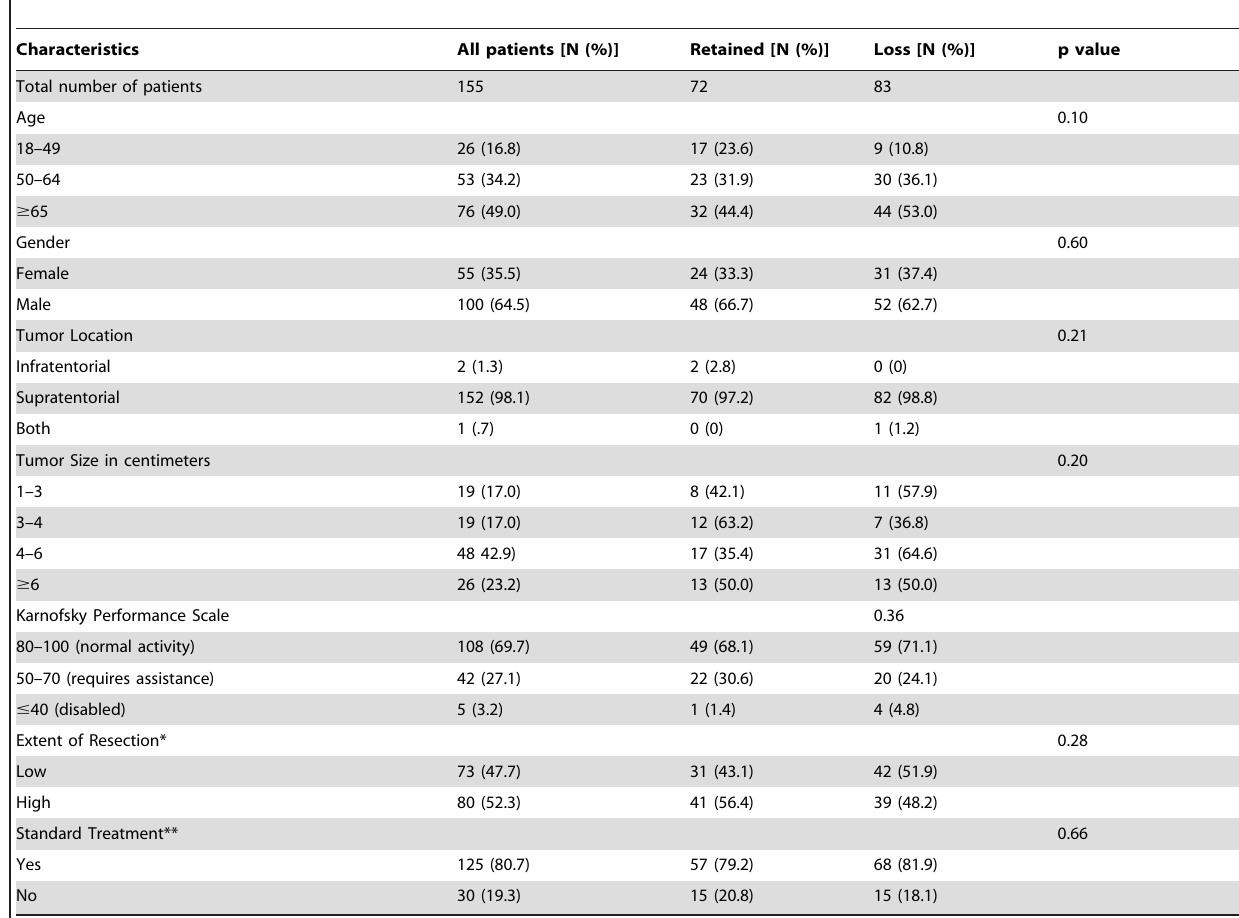
Table 1. Patient and tumor characteristics stratified by PTEN expression (retained vs. loss).